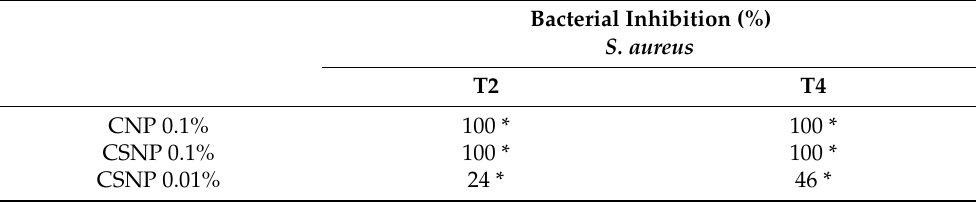
Table 5. Bacterial inhibition (in%) obtained in dynamic contact antimicrobial tests of leather samples obtained from the industrial phase E containing nano/microformulations of chitosan (CNP 0.1%, CSNP 0.1% and 0.01%) against S. aureus . Bacterial Inhibition (%) S. aureus T2 T4 CNP 0.1% 100 * 100 * CSNP 0.1% 100 * 100 * CSNP 0.01% 24 * 46